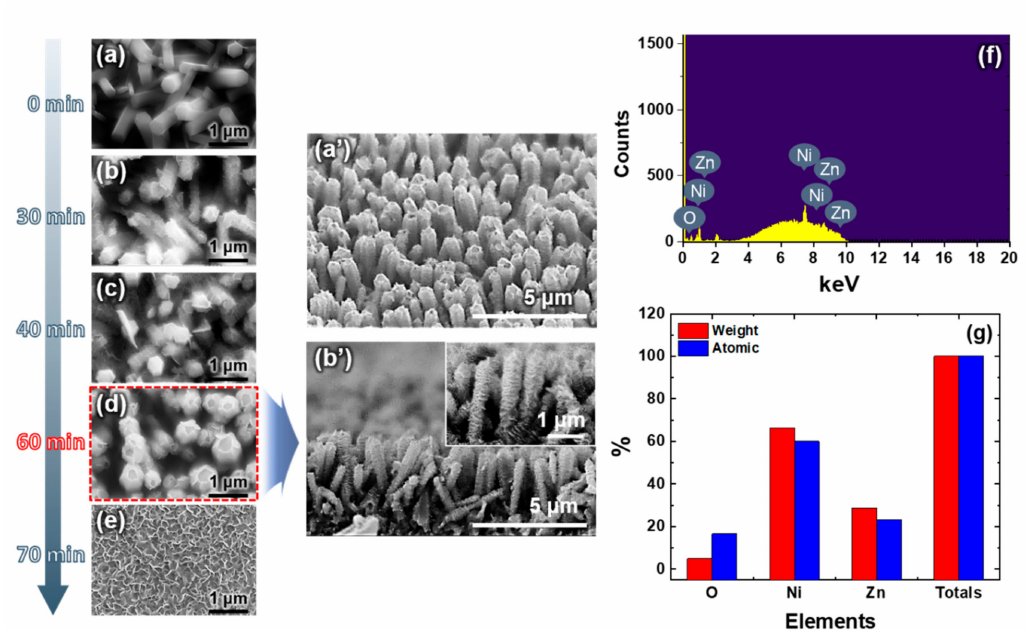
Figure 2. Field emission-scanning electron microscope (FESEM) images of ( a ) ZNRs and ( b – e ) hierarchical ZNR / NNS arrays grown for di ff erent times; ( a’ ) tilt and ( b’ ) cross-sectional FESEM images of ( d ). ( f ) an energy-dispersive spectroscopy (EDS) and ( g ) atomic composition of the hierarchical ZNR / NNS